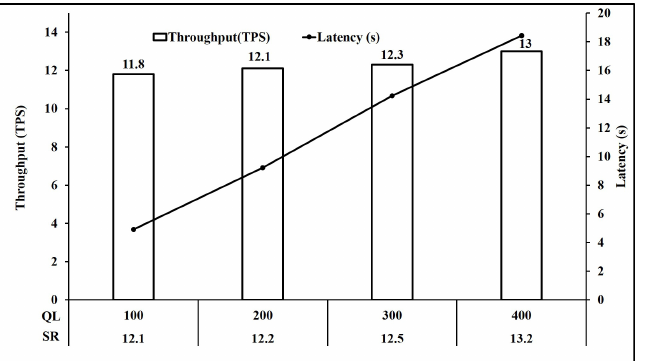
Figure 9. Read operation- Peak Throughput: FT- 846.7 TPS, NFT- 845.2 TPS (Queue Length: QL, Send Rate (TPS): SR).